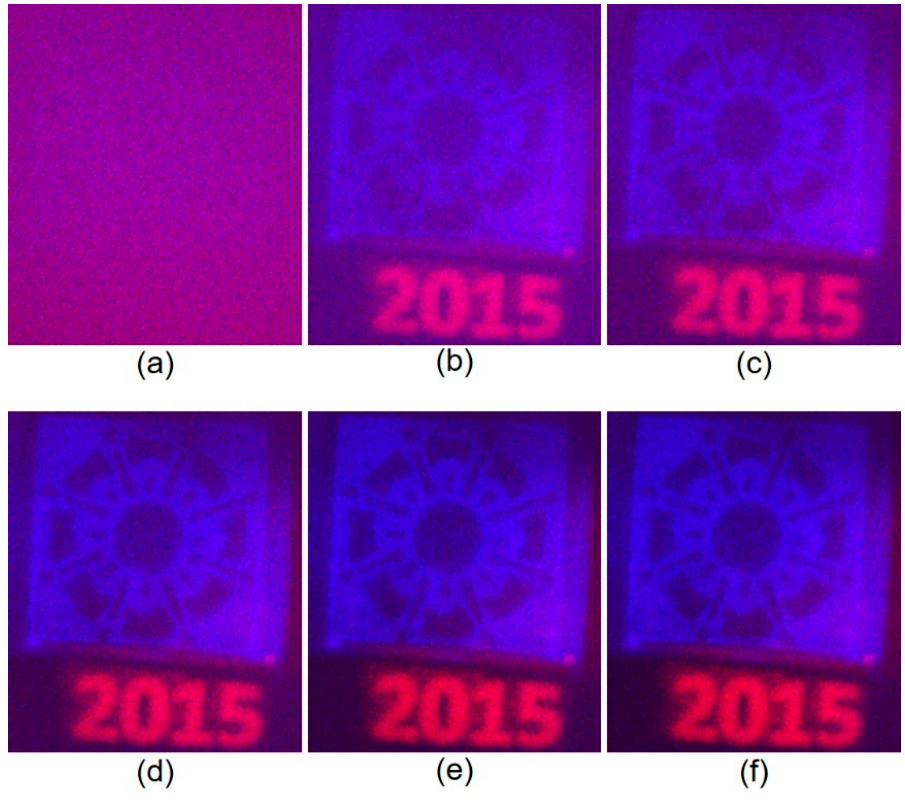
Figure 2. Experimental results: reconstructed images when bit depths of holograms are compressed to ( a ) 2, ( b ) 3, ( c ) 4, ( d ) 5, ( e ) 6, and ( f ) 7 bits.